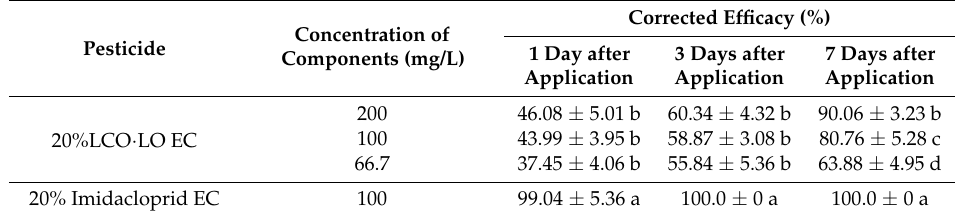
Table 7. The result of field trials of 20% LCO · LO EC on Aphis citricola van der Goot (October 2008, Baishui,